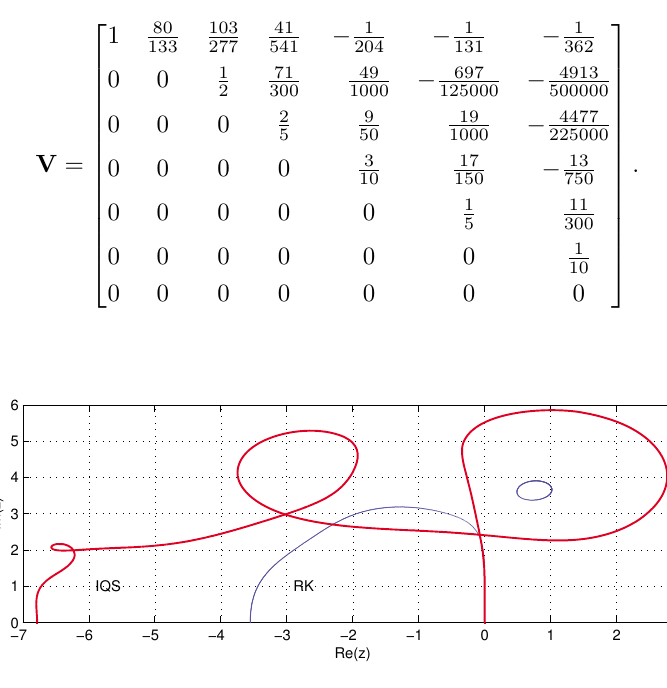
Figure 10. Stability regions of GLMs with p = q = s = 6, r = 7 with IQS and of an approximation of order 6 of the function exp( z ).